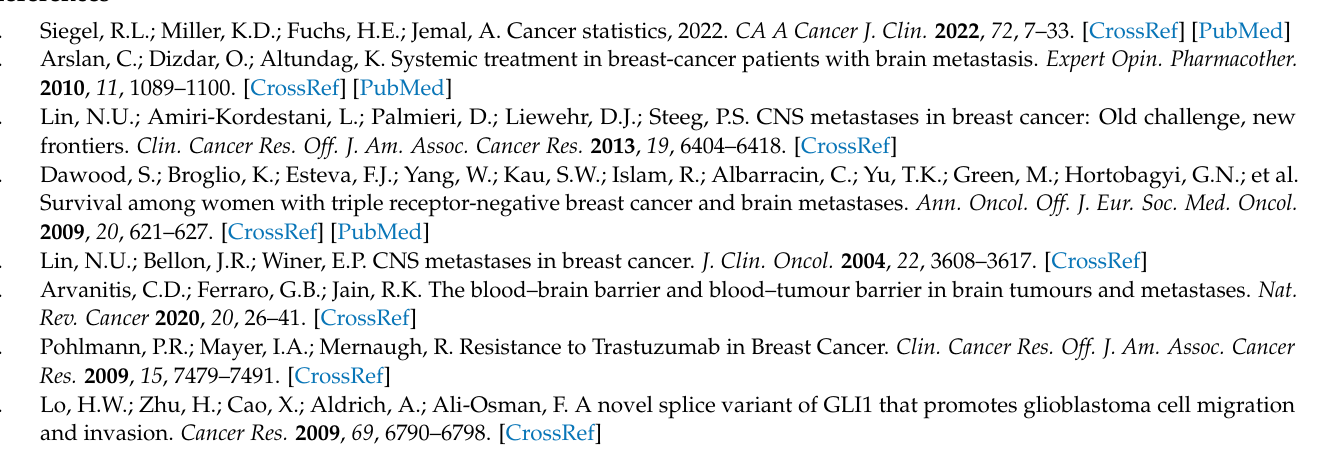
cells, and human astrocytes. Figure S5: Novel KCZ derivatives. Figure S6: KCZ-7 does not reduce SKBRM-tGLI1 lung metastasis progression. Figure S7: ITZ does not reduce the progression of SKBRM-tGLI1 metastases in vivo. Figure S8: KCZ and KCZ-7 treatment reduce the expression of tGLI1-mediated stemness genes Nanog and OCT4 in MDA-MB-231 cells. Figure S9: The sequence of the recombinant N-tGLI1 protein as determined by mass spectrometry. Figure S10: The expression of validated tGLI1 target genes after treatment with KCZ or KCZ-7 in isogenic SKBRM cell lines. Figure S11: The expression of validated tGLI1 target genes after treatment with KCZ or KCZ-7 in isogenic MDA-MB-231 cell lines. Figure S12: Nanog and OCT4 overexpression in transfected SKBRM-tGLI1 cells. Figure S13: The pLM303-tGLI1 recombinant protein purification. Table S1: RT-qPCR primers. Table S2: Drug screening results in isogenic MDA-MB-231 and MDA-MB-231BRM lines. References [10–14,24] are cited in the Supplementary